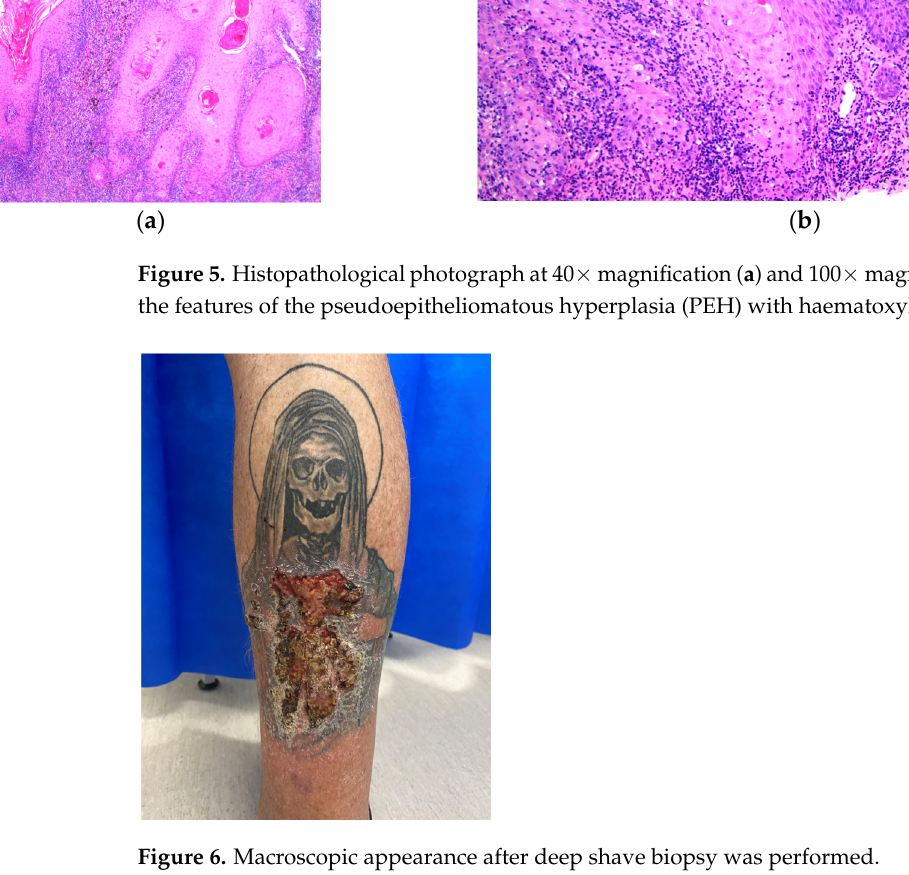
Figure 5. Histopathological photograph at 40× magnification ( a ) and 100× magnification ( b ) showing the features of the pseudoepitheliomatous hyperplasia (PEH) with haematoxylin eosin stain (H&E).